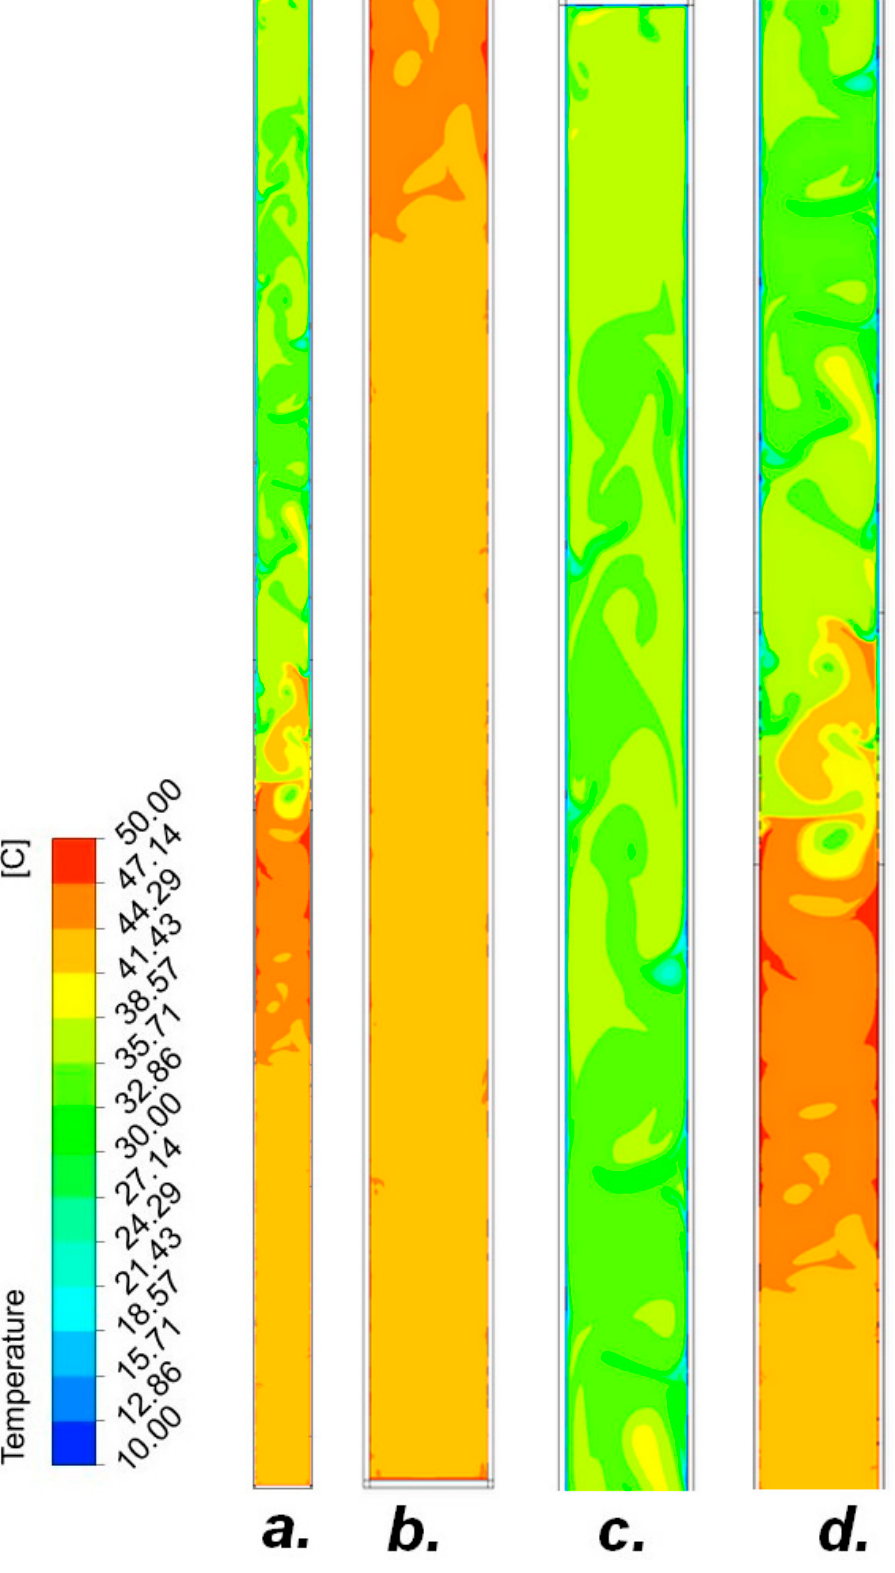
Figure 32. Temperature distribution in the heat pipe. ( a ) Total heat pipe; ( b ) evaporator section; ( c ) condenser section; ( d ) isothermal section.